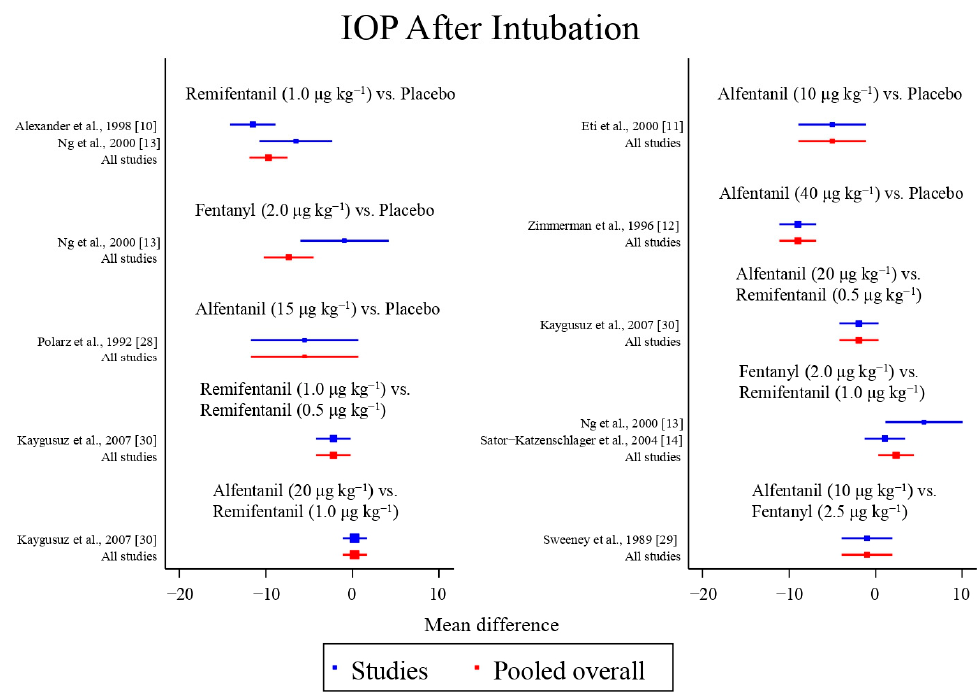
Figure 4. The network meta-analysis forest plot. The blue dots and lines indicate the studies contributing the direct evidence. The red dots and lines indicate the pooled overall network estimates of the treatment effects. See refs [10–14,28–30].